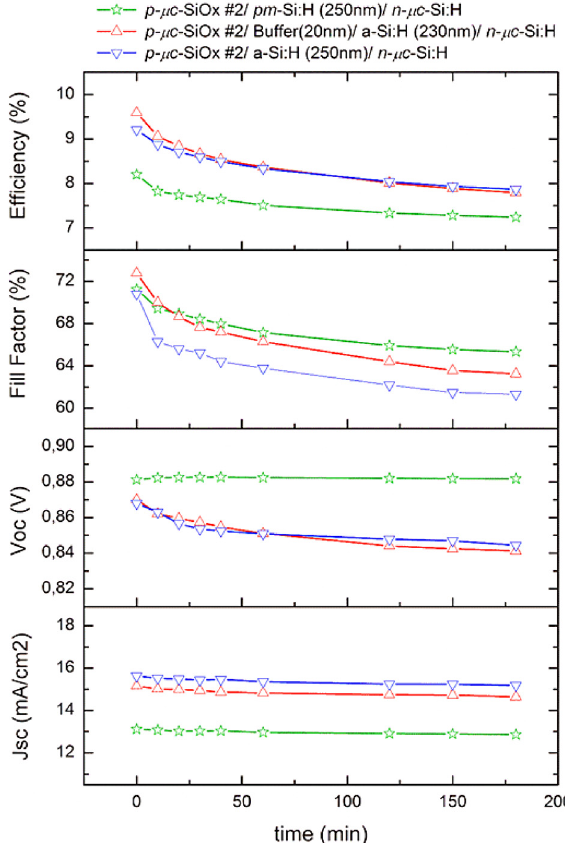
Fig. 5. Evolution of photovoltaic parameters of three differ- ent p - i - n solar cells during the light-soaking under a halogen lamp illumination at 2 suns. All three cells are fabricated on LPCVD ZnO using sputtered ZnO-Ag back contacts; their p - i - n structures are shown at the top of graph. Note that the J - V -characteristics are measured using the same halogen lamp at 1 sun and 50 ◦